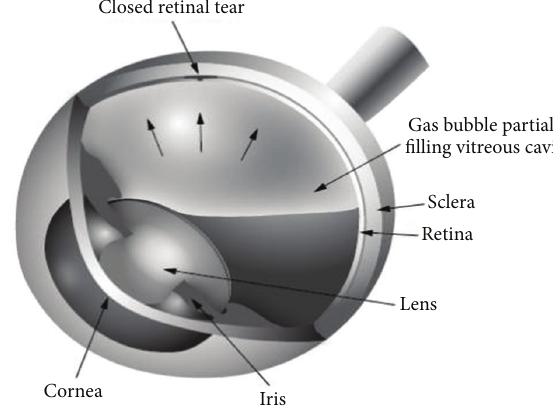
Figure 2: Drawing showing the appearance of an intraocular gas bubble. The surface tension of the air bubble helps to seal a retinal tear. This allows for the use of laser or cryotherapy to scar down the retina surrounding the hole, so the retina remains attached after the bubble is